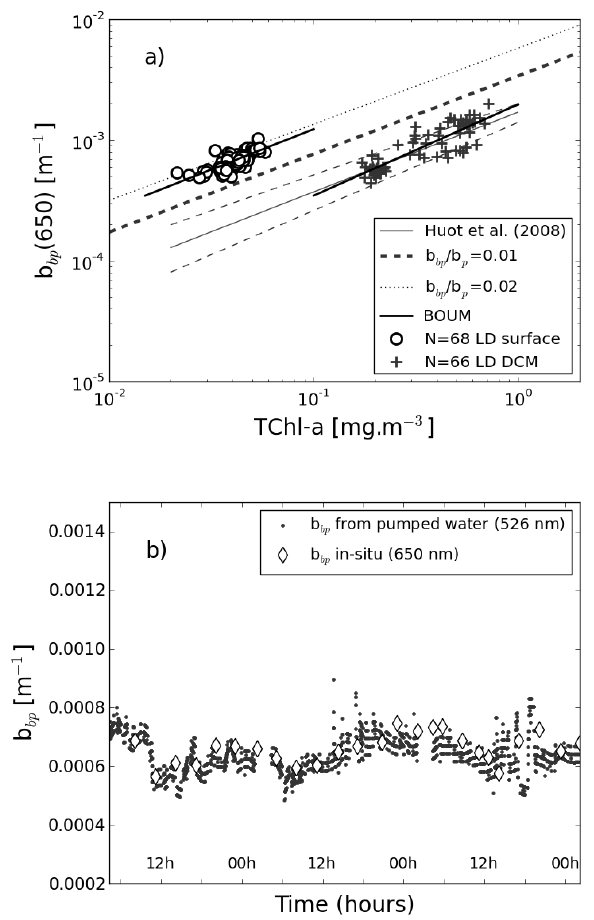
Fig. 7. (a) Variations of the particulate backscattering coefficient, Figure 7. b bp (660), as a function of the TChl- a concentration for the sur- face layer (cross), and at the DCM (circle). The two solid lines are the least squares linear fits described by the Eqs. (11) (surface layer) and (12) (DCM). The dashed and doted lines represent the semi-analytical model of Morel and Maritorena (2001), in which the mean formulation used between b p and TChl- a is replaced by the empirical formulation developed over the BOUM data set (Eq. 7), and for two different values of the backscattering ratio, b bp / b p , as indicated. The solid grey line represents the empirical formulation of Huot et al. (2008), and the two grey dashed lines delimit the 95% confidence interval as given in Huot et al. (2008) (their Ta- ble 1). (b) Comparison between the in situ b bp (650) measurements and the b bp (526) measurements performed in the wet lab on surface pumped water at station B.